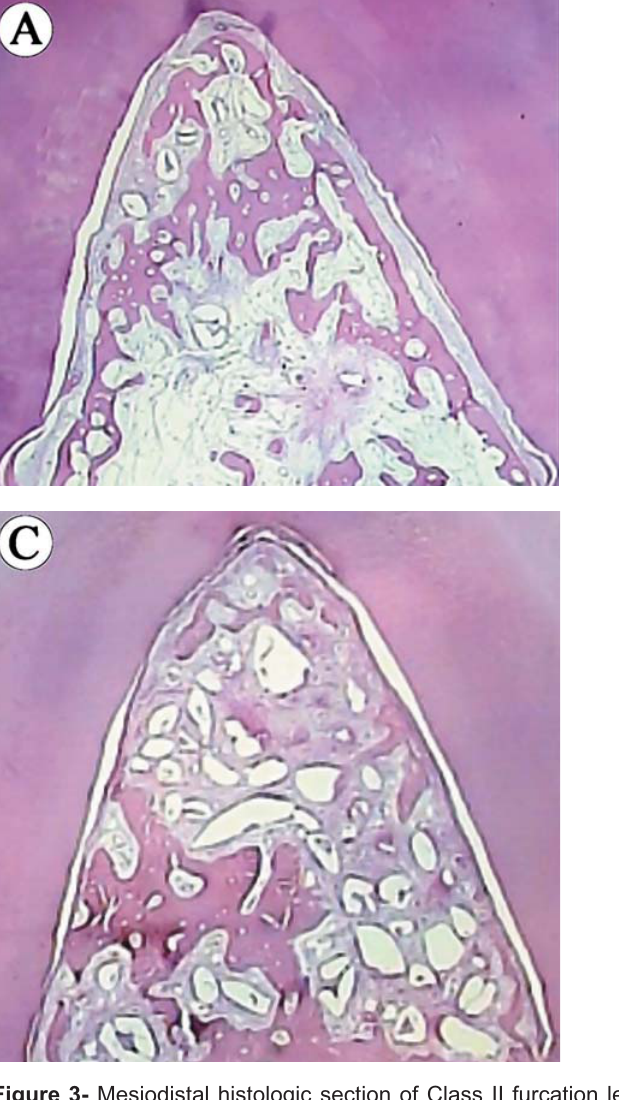
different time periods and the interaction between